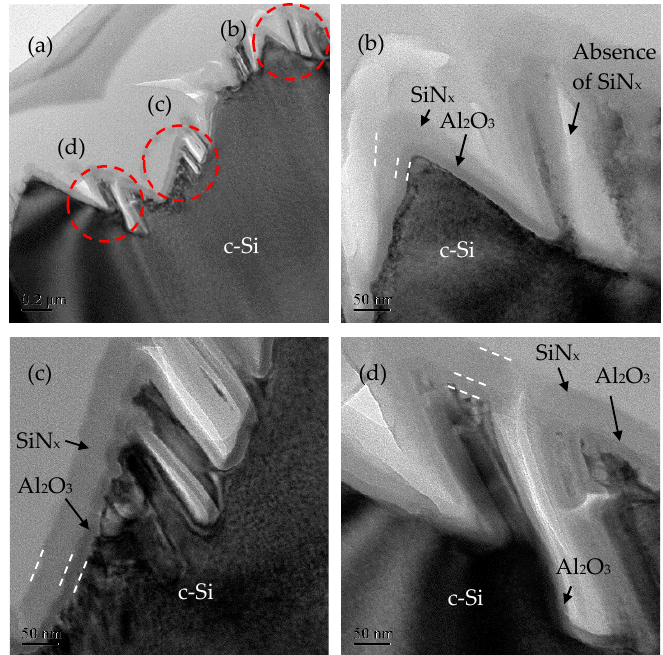
Figure 9. ( a ) Cross-sectional transmission electron microscope (TEM) images for black silicon with a MACE time of 3 min and SiN x / Al 2 O 3 passivation layers. The red circles are di ff erent locations in the black silicon wafer, and ( b – d ) are their close-up